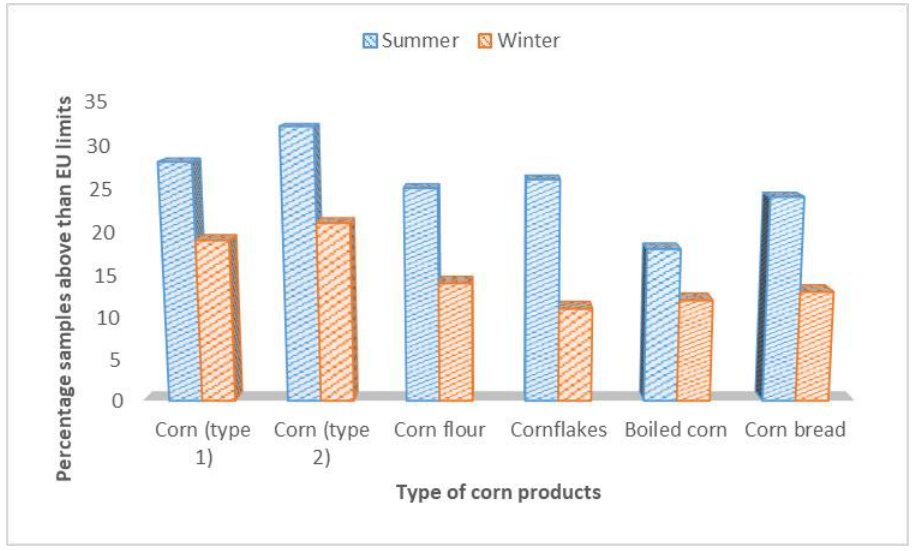
Figure 2. Comparison of sample of corn and products having levels of DON higher than EU limits.